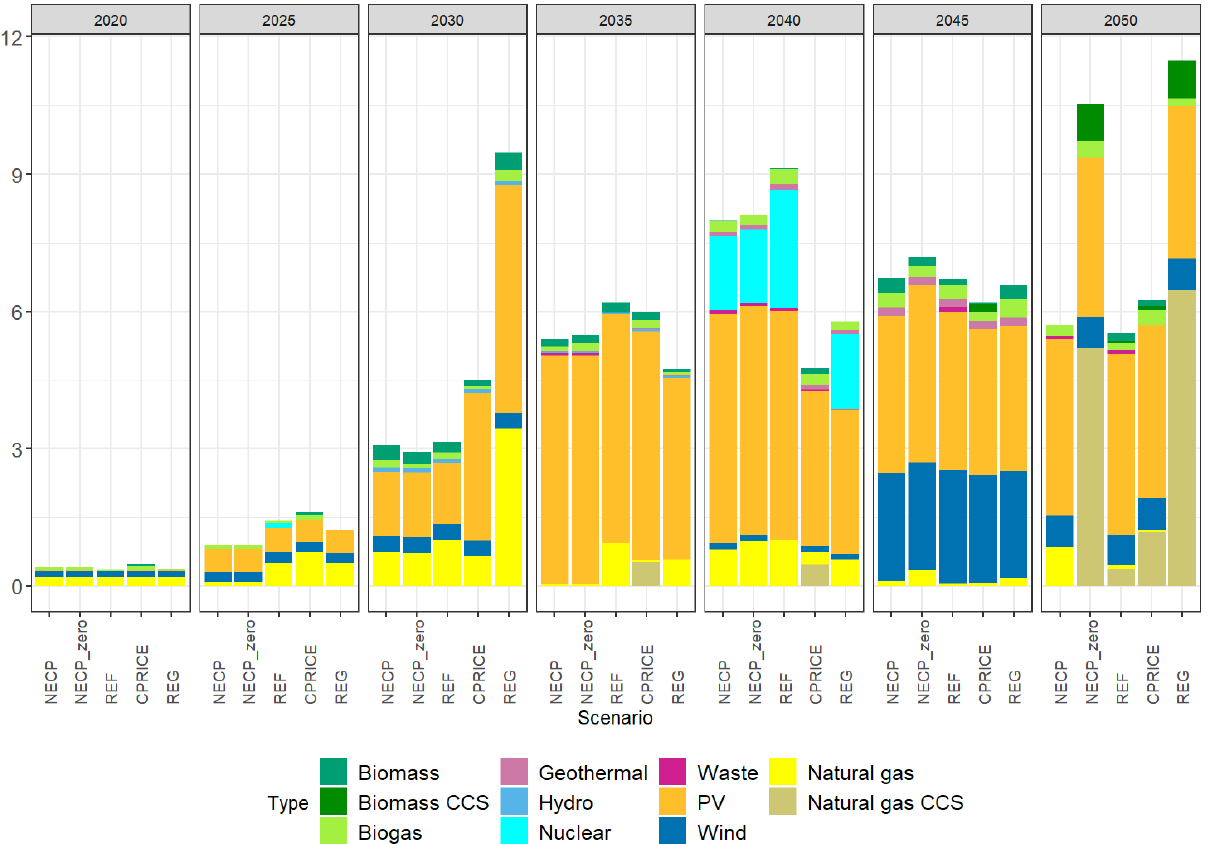
Figure 3. New installed electricity generation capacity — 5-year increments.